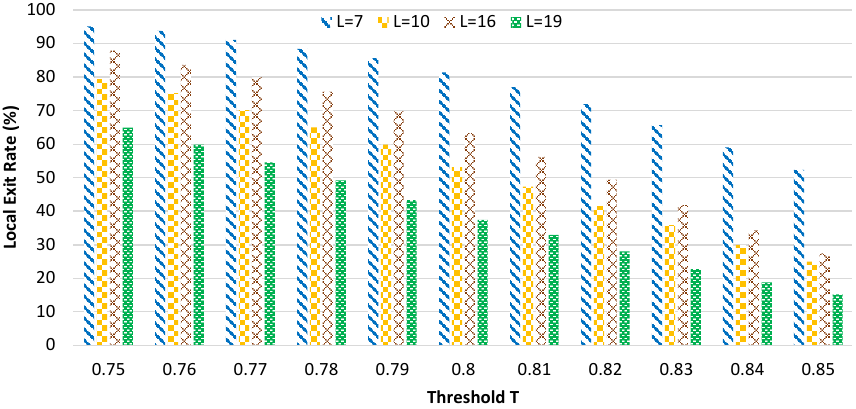
Figure 9. Histogram of the local based on four segmentation points.